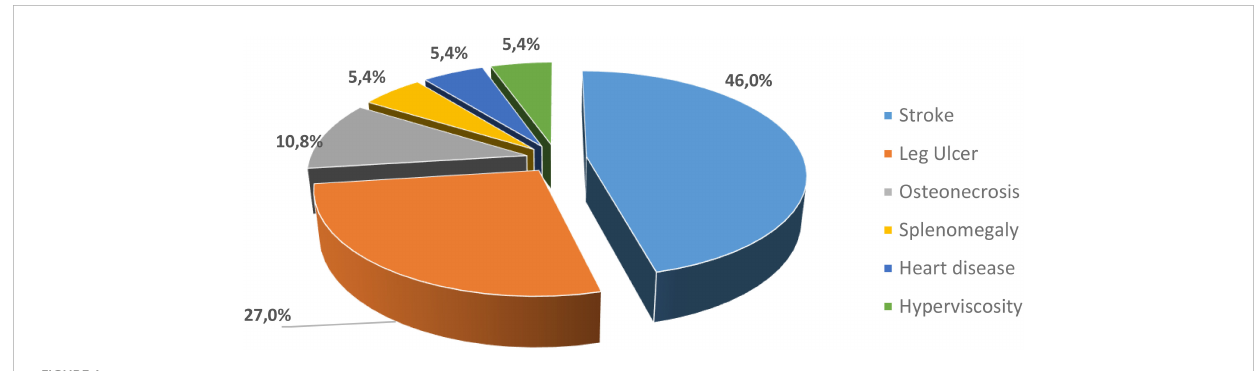
FIGURE 1 Frequency of complications in our SCD patients .